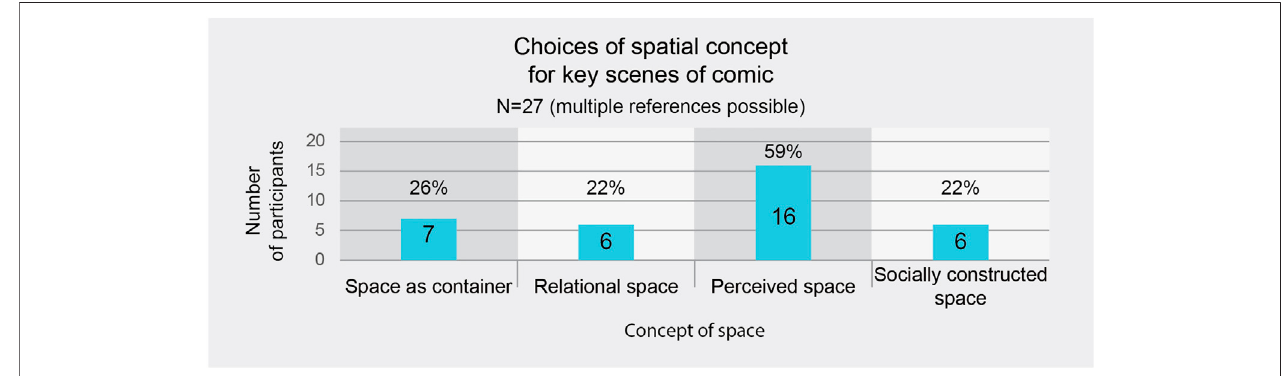
FIGURE 3 | Choices of concepts of space (after Wardenga, 2002) among the participants for their own